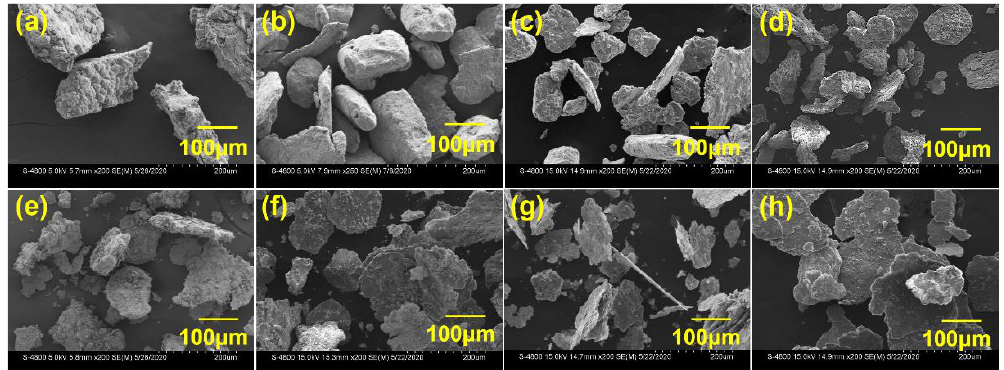
Figure 3. SEM images of Al-LMP alloy powder. ( a ) Plates, ( b ) crushing powders, ( c ) 0% NiCl 2 (1 h), ( d ) 2% NiCl 2 (1 h), ( e ) 4% NiCl 2 (1 h), ( f ) 6% NiCl 2 (1 h), ( g ) 2% NiCl 2 (2 h), ( h ) 2% NiCl 2 (3 h).